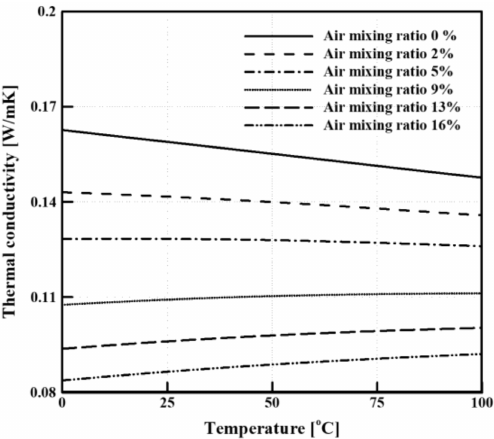
Figure 4. The thermal conductivity [W/m · K] of the oil and air